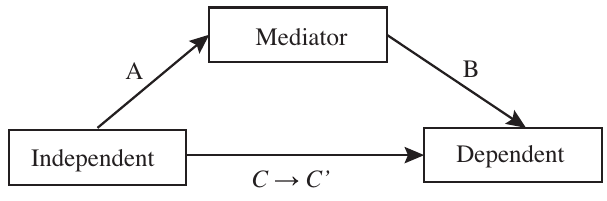
FIG. 1. Mediation